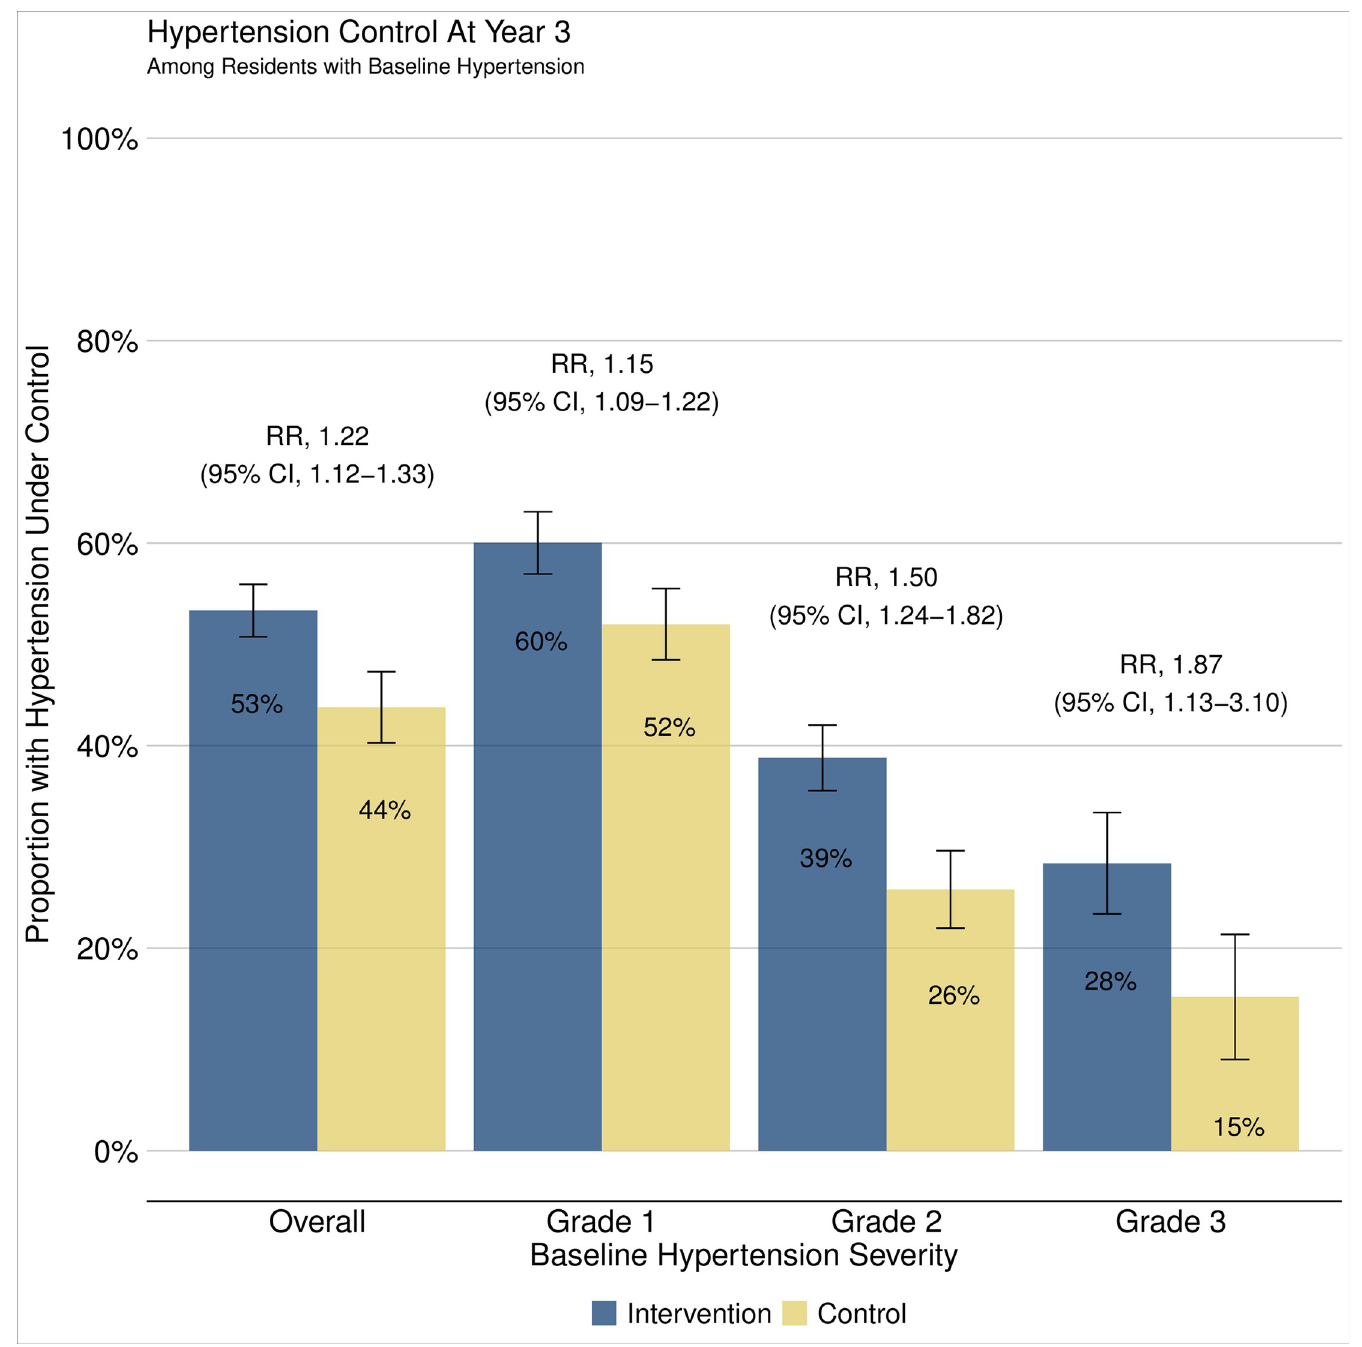
Fig 4. Hypertension control at year 3. Estimates obtained using 2-stage TMLE to estimate and compare community-level hypertension control at year 3 population- level BP measurement. Vertical error bars depict arm-specific 95% CIs. Hypertension control defined as lowest of 3 BPs < 140/90 mm Hg at year 3 follow-up measurement. Baseline hypertension severity defined by lowest of 3 BP measurements and classified as Grade 1 (BP 140–159/90–99 mm Hg), Grade 2 (BP 160–179/ 100–109 mm Hg), Grade 3 (BP � 180/110 mm Hg). BP, blood pressure; CI, confidence interval; RR, relative risk; TMLE, targeted maximum likelihood estimation.